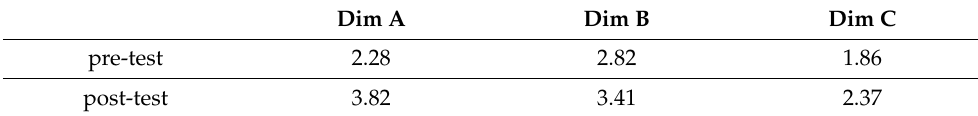
Table 3. Average scores in individual dimensions.